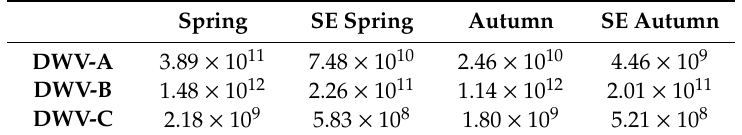
Table 1. Mean apiary level deformed wing virus (DWV) viral load and standard error (SE), per season and variant in English and Welsh colonies.